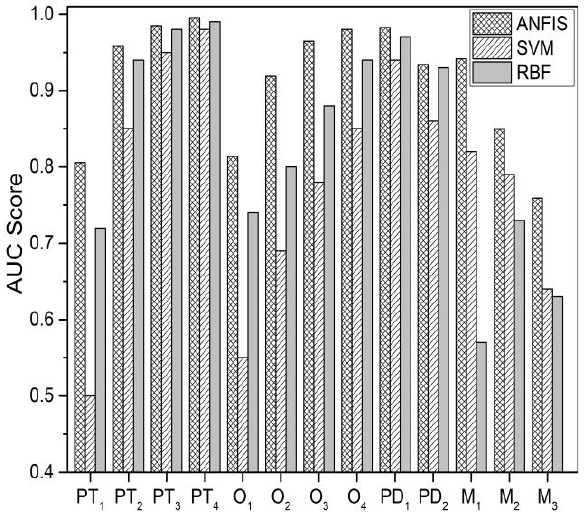
Figure 12. Area under curve (AUC) metric for the ANFIS, radial-basis-function neural network (RBF), support vector machines (SVM) classifiers for all the power theft scenarios of Table 1. Table 4. Classification performance metrics calculation for each power theft scenario (13 in total). Accuracy Recall F1 Precision